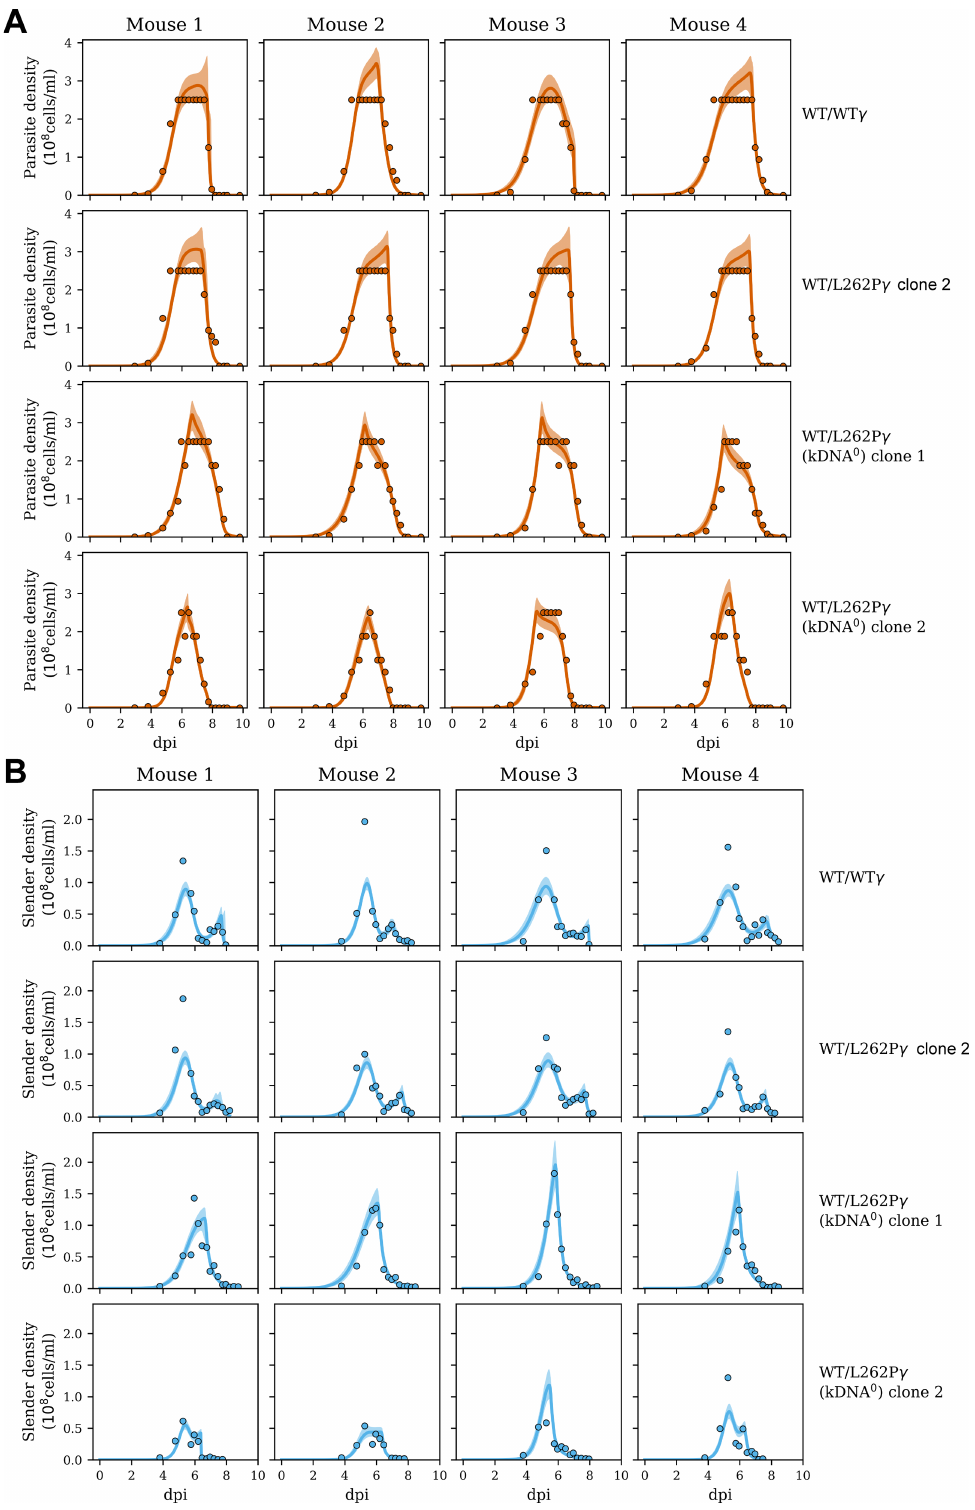
Fig 5. Comparison of mathematical model and data from mouse infections. The data is represented by filled dots. The coloured lines represent median fits of the model (including terms for both SIF-dependent and -independent differentiation); the shaded regions indicate 95% predictive intervals, where 95% of future data would be predicted to